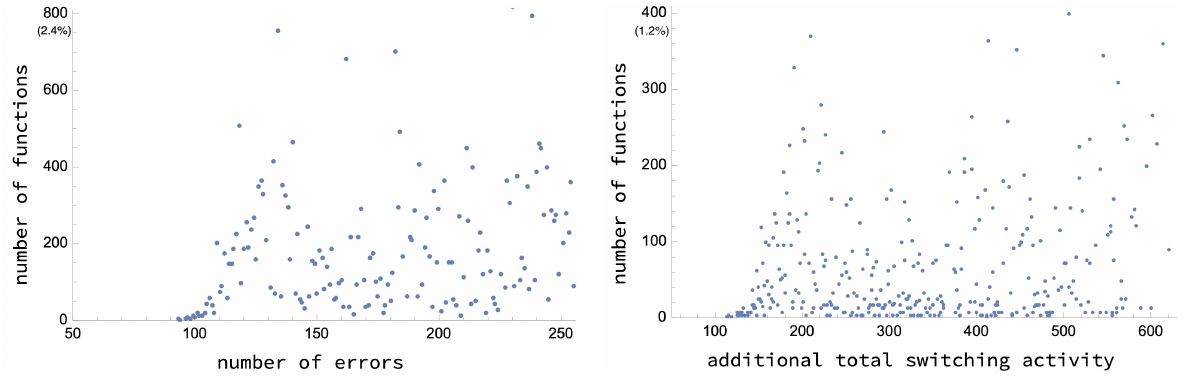
Figure 3. Tally counts according to the number of errors to MAJ and the additional total switching activity, among 2 15 = 32,768 possible circuits using NAND and NOR gates; test.